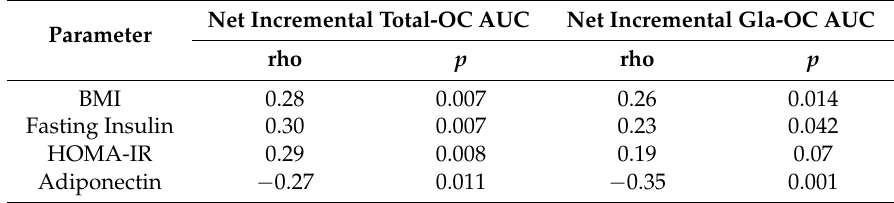
Table 3. Spearman rank correlation between net incremental area (under total osteocalcin and carboxylated osteocalcin) and BMI and biochemical